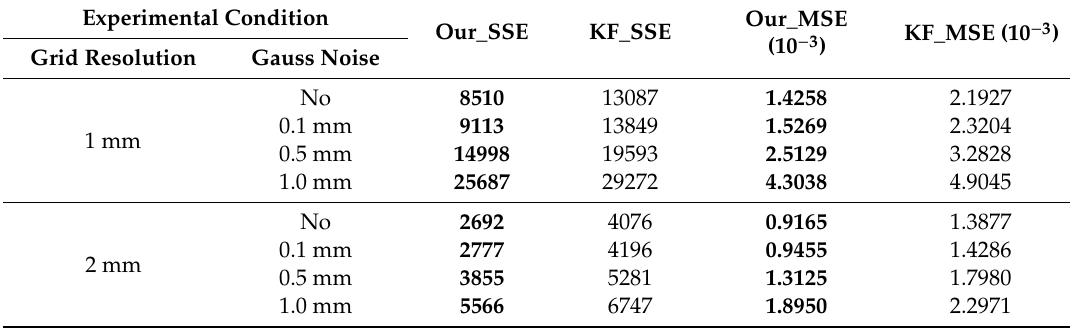
Table 3. Quantitative analysis results of texture reconstruction accuracy at di ff erent noise